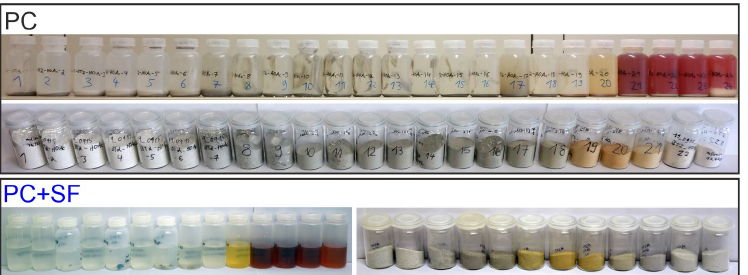
Figure 1. Photographs of selected suspensions before filtration and of the solids after filtration for PC, as well as some of the liquid and solid fractions after filtration for PC + SF (for each series with decreasing pH from left to right). decreasing pH from left to